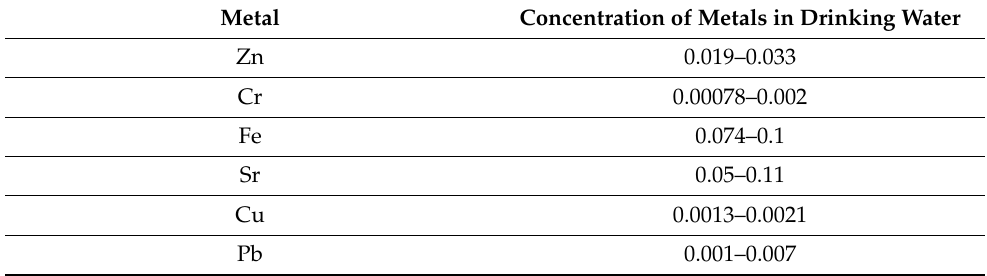
Table 5. Concentration range of metals entering the body with drinking water consumption ( µ g/L).